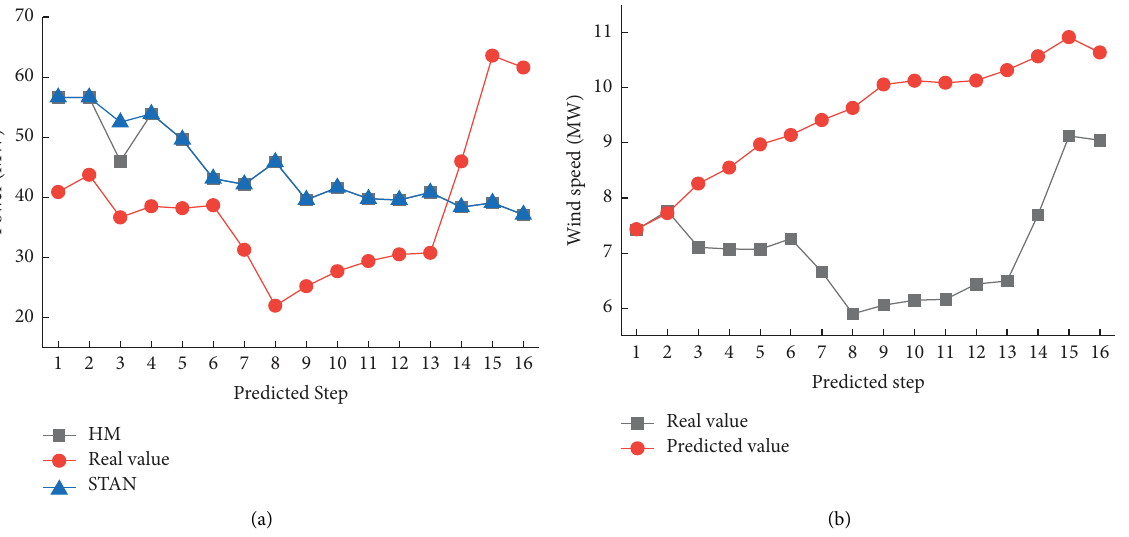
Figure 8: Applicability analysis of HM model for high WS fuctuation scenarios: (a) power prediction curve and (b) wind speed correction curve.